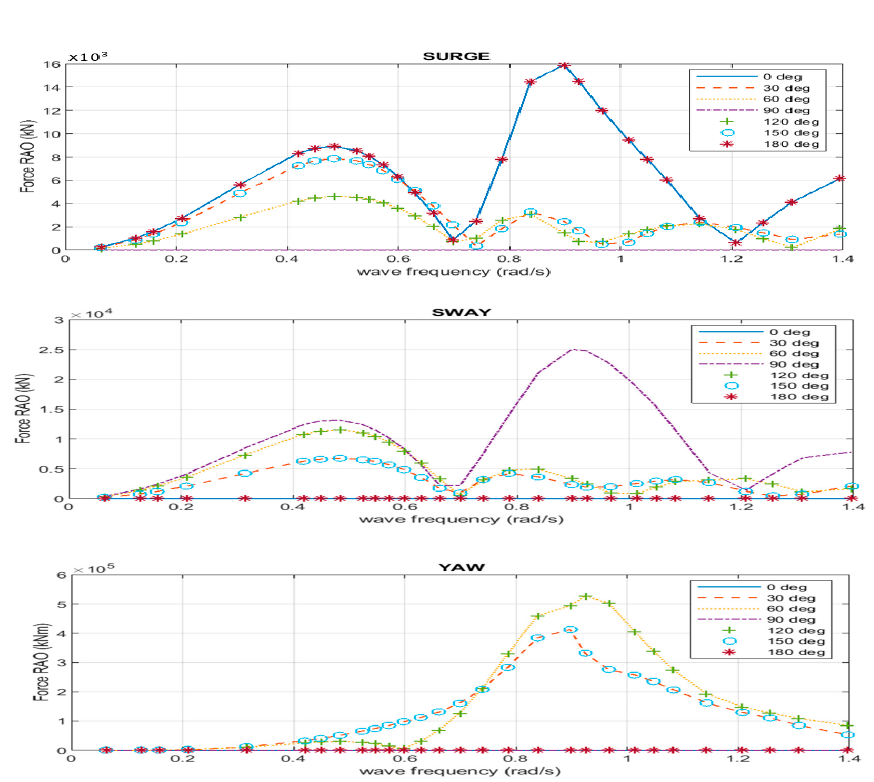
Figure 5. First-Order wave loads.